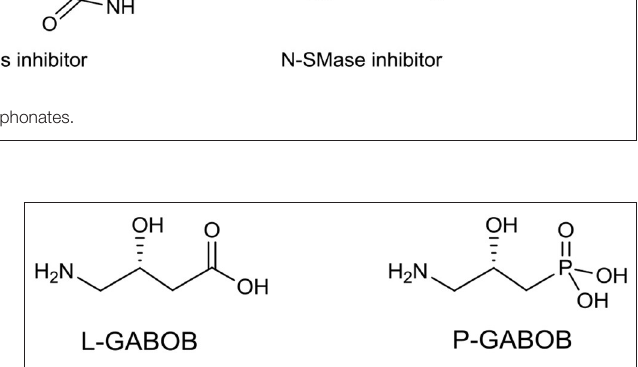
FIGURE 2 | Structures of ( R )- β -hydroxy- γ -aminobutanoic acid (L-GABOB) and its organophosphorus analogs